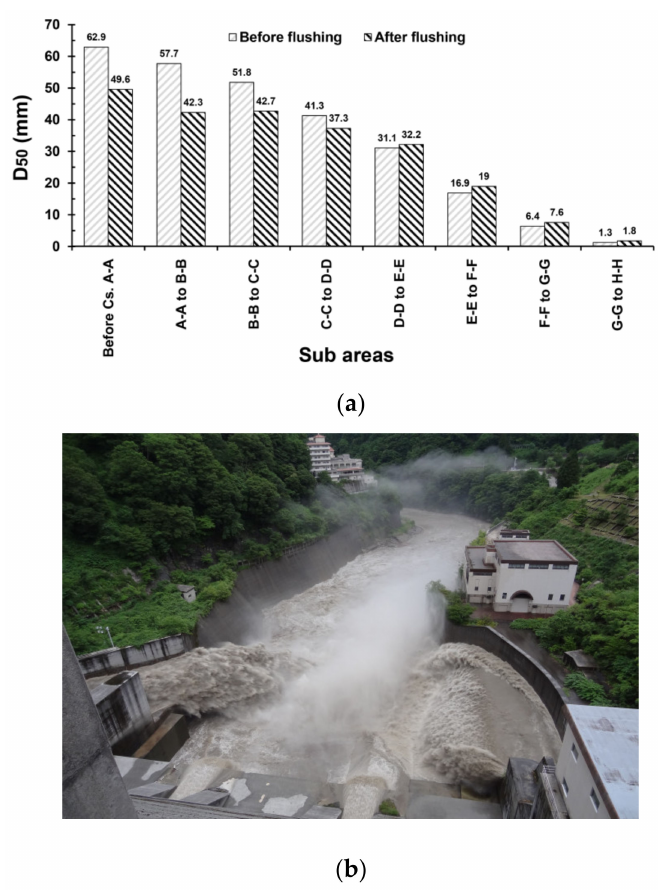
Figure 5. ( a ) Comparison between average sediment size (i.e., D 50 ) before and after the 2012 flushing operation in different subareas in the Unazuki Reservoir. ( b ) Photograph taken during a sediment- flushing operation showing the water-sediment mixture released from bottom outlets in the Un- azuki